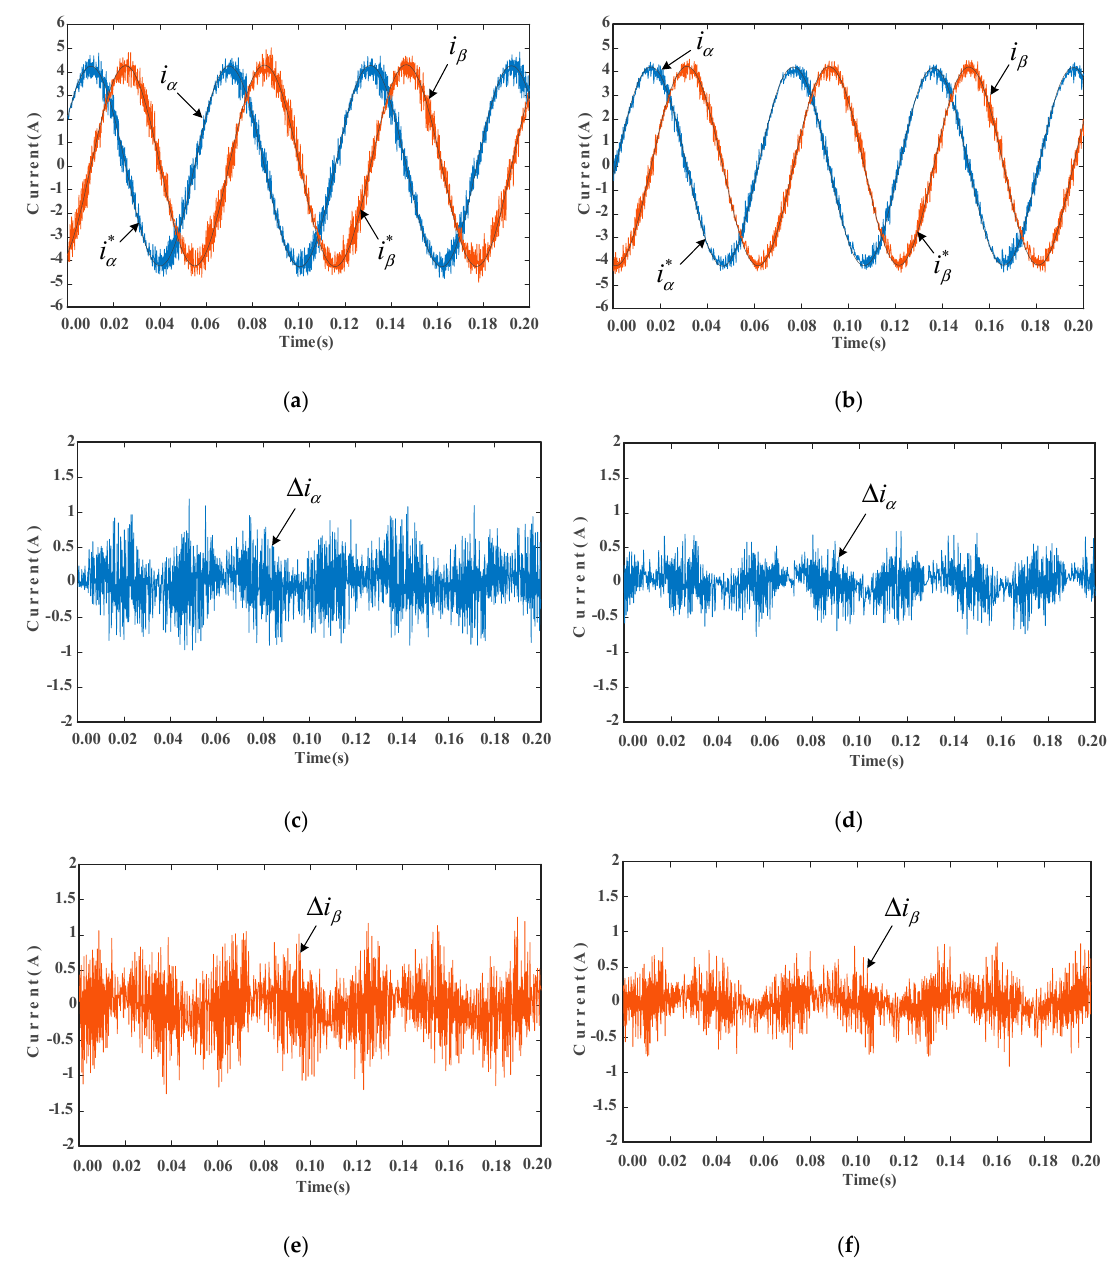
Figure 13. Currents and current errors under constant speed of 500 rpm and load-torque of 2 N-m: ( a ) current responses of the MPCC without modulation, ( b ) current responses of the proposed MPCC, ( c ) the α -axis current error of Figure 13a, ( d ) the α -axis current error of Figure 13b, ( e ) the β -axis current error of Figure 13a, and ( f ) the β -axis current error of Figure 13b.